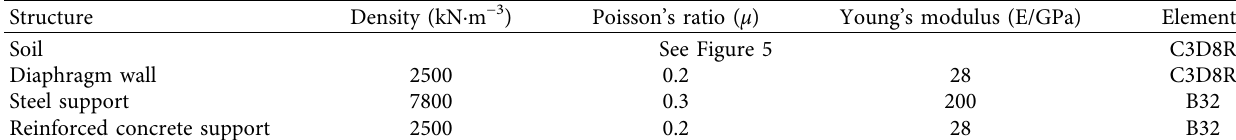
Table 3: Physical and mechanical parameters of the support